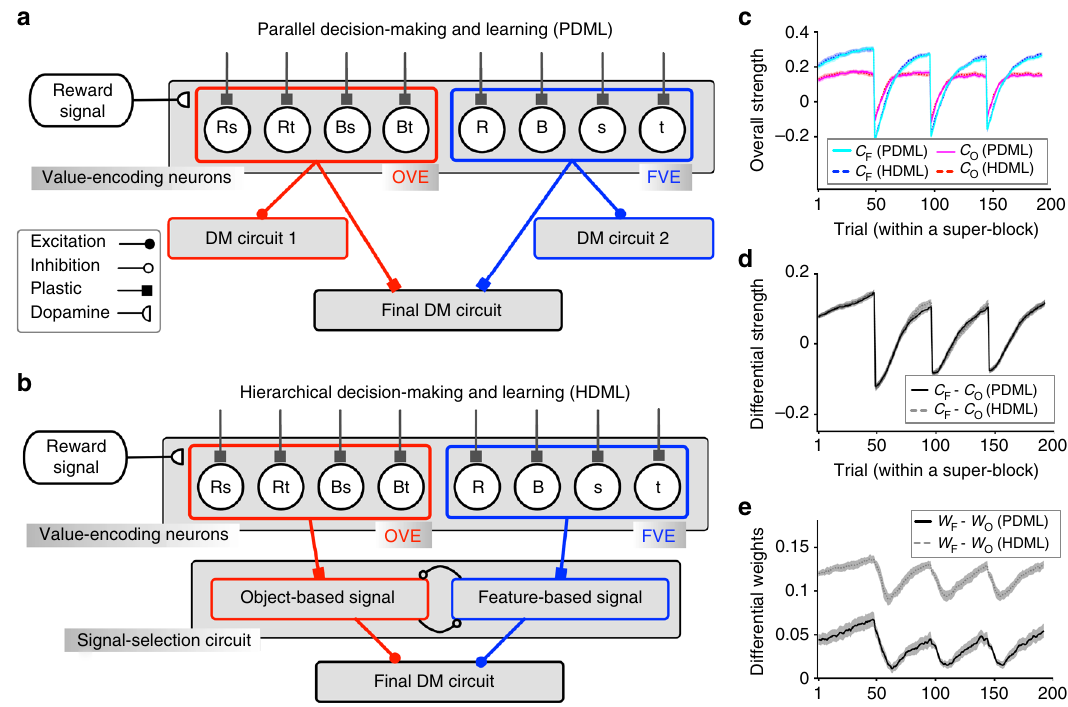
Fig. 6 Architectures and performances of two alternative network models for multi-dimensional, decision-making tasks. a , b Architectures of the PDML ( a ) and the HDML ( b ) models. In both models, there are two sets of value-encoding neurons that estimate reward values of individual objects (object-value- encoding neurons, OVE) and features (feature-value-encoding neurons, FVE). The two models are different in how they combine signals from the OVE and FVE neurons and how the in fl uence of these signals on the fi nal decision is adjusted through reward-dependent plasticity. c The time course of the overall strengths of plastic synapses between OVE and FVE neurons and the fi nal DM circuit ( C O and C F ) in the PDML model, or between OVE and FVE neurons and the signal-selection circuit ( C O and C F ) in the HDML model. These simulations were done for the generalizable environment (Experiment 1) where the block length was 48. d The difference between the C F and C O over time in the two models. e The difference in the overall weights of the two sets of value- encoding neurons on the fi nal decision ( W F – W O ) for the same set of simulations shown in c ,